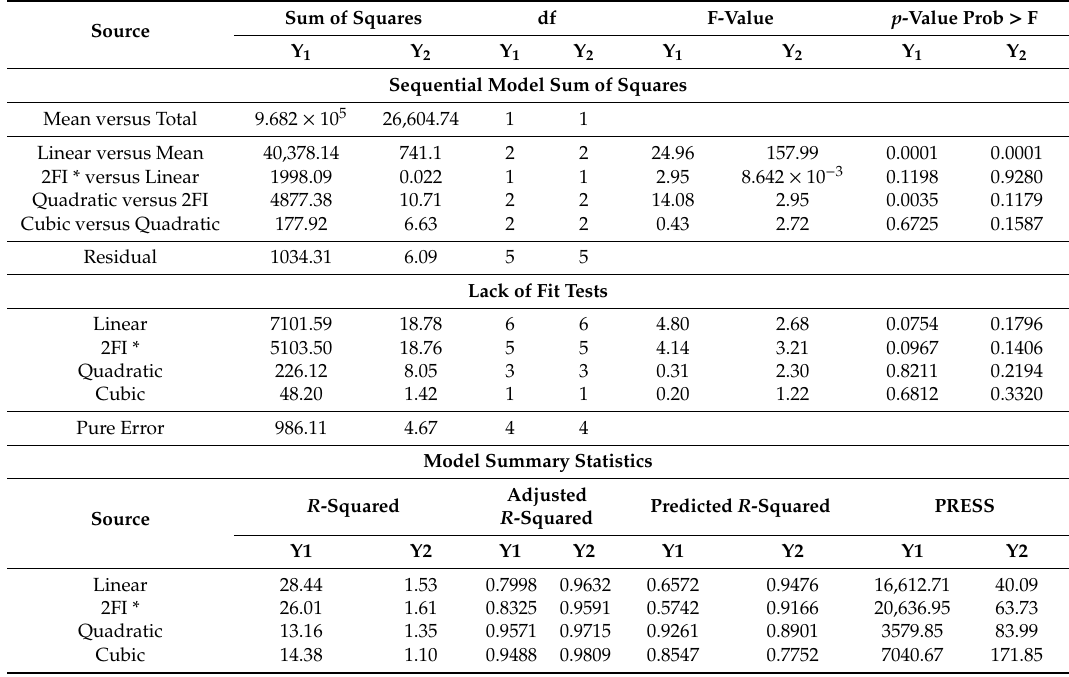
Table 3. Fit summary for the responses particle size (Y 1 ) and entrapment e ffi ciency (Y2) by 3 2 full factorial design.